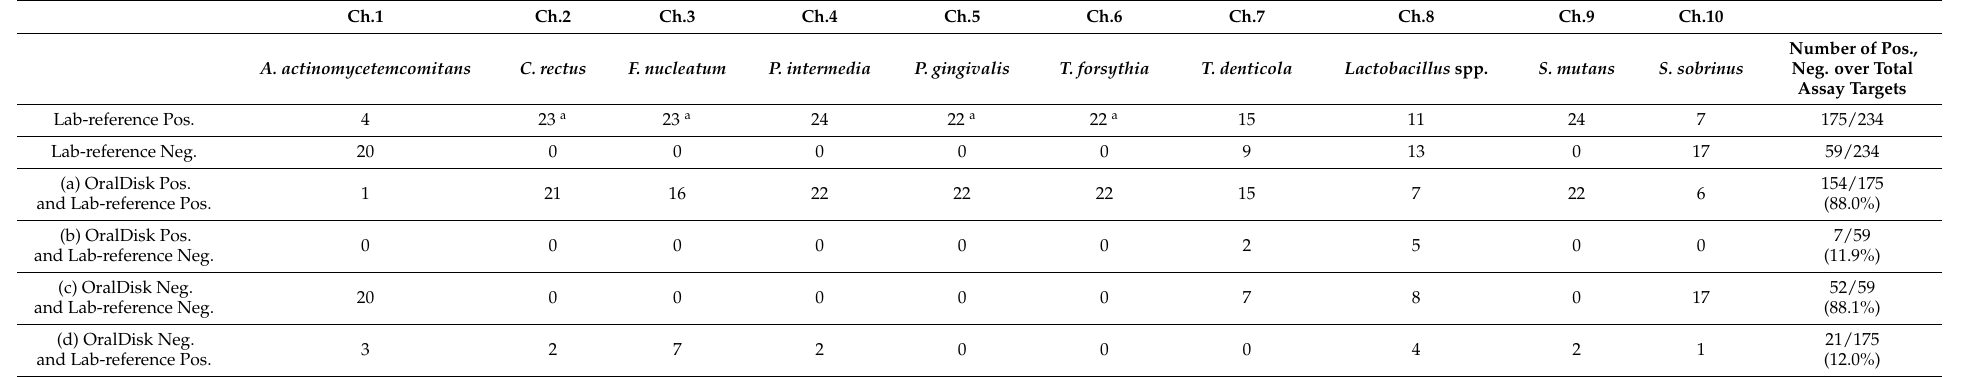
Table 1. Comparison of the lab-based reference versus the OralDisk for positive/negative results. Each number in the table denotes the number of times an assay target was detected in the OralDisk and lab-based reference experiments. ‘Ch.1–Ch10’ refers to the numbering of the respective OralDisk chamber where each assay target was detected. ‘Pos.’ and ‘Neg.’ are abbreviations for ‘positive’ and ‘negative’, respectively.